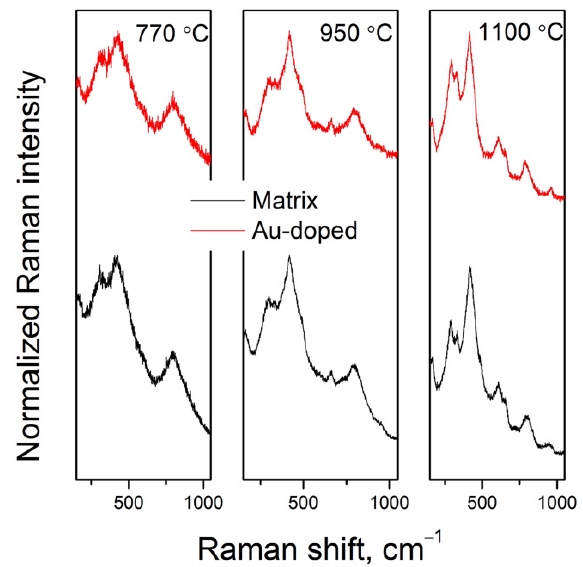
Figure 9. Raman spectra of the glass samples heat treated in the 770–1100 °C range for 20 h for the Matrix and Au-doped series.